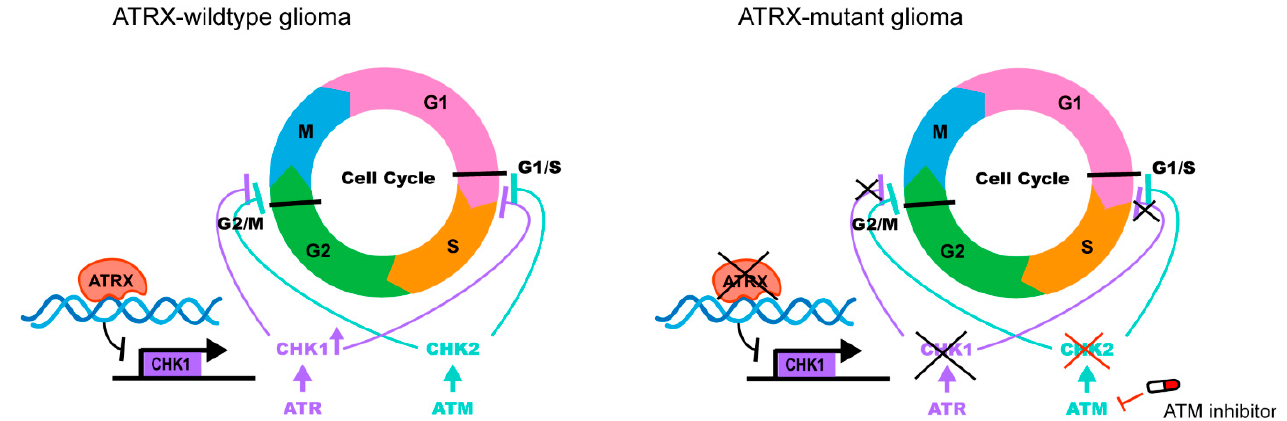
Figure 6. ATRX binds the regulatory elements of the cell cycle phase transition gene CHEK1 in glioma. ATRX deficiency results in reduced CHK1, which increases reliance on ATM. ATRX loss impaired the ability to maintain the G2/M cell-cycle checkpoint after radiation, and improved radio-sensitization with ATM inhibitors.